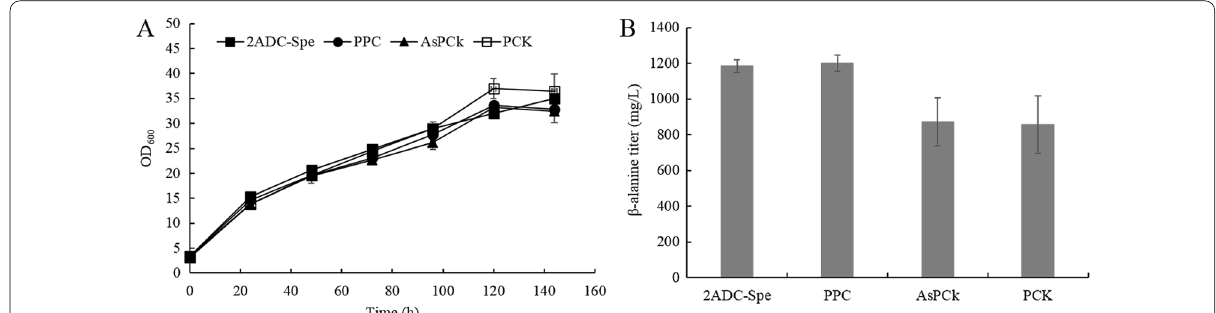
Fig. 6 The effects of strengthening PEP carboxylation on β-alanine production. A Growth profiles of recombinant strains; B β-alanine production in recombinant strains at the end of fermentation. Three parallel flasks are tested for each strain. Error bars represent deviations ( n